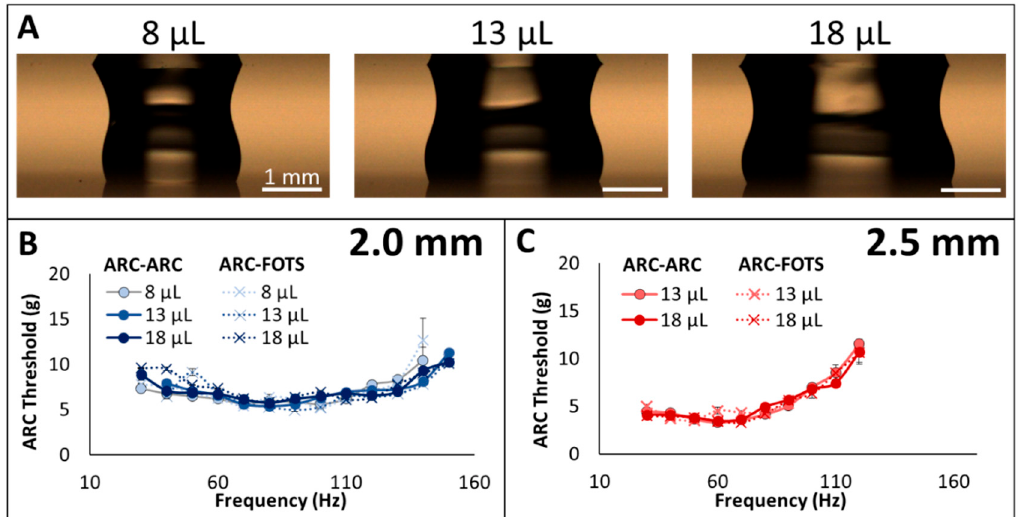
Figure 4. Anisotropic ratchet conveyor (ARC) threshold is independent of droplet volume in dual-plate system. ARC threshold values are similar for droplets of different volume ( A ) transported in 2.0 mm ( B ) and 2.5 mm ( C ) tracks. On open ARC systems, ARC threshold profiles are dependent on droplet volume [22], thus these profiles demonstrate that the ARC threshold profiles scale with vertical movement of the center of mass of the droplets. Error bars indicate ± standard deviation; scale bars on droplet images represent 1 mm.